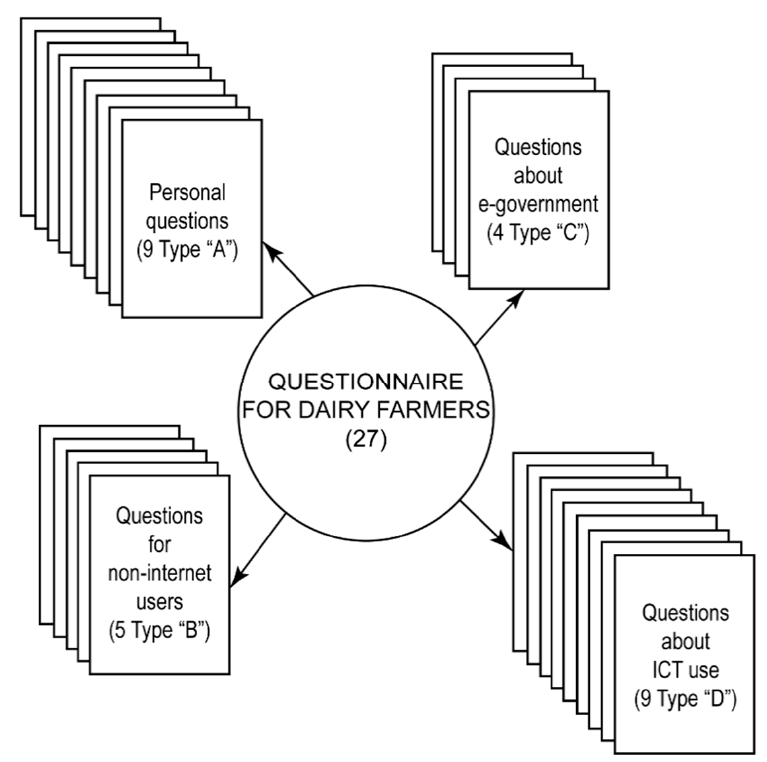
Figure 4. Questionnaire. Typology and Number of Questions.